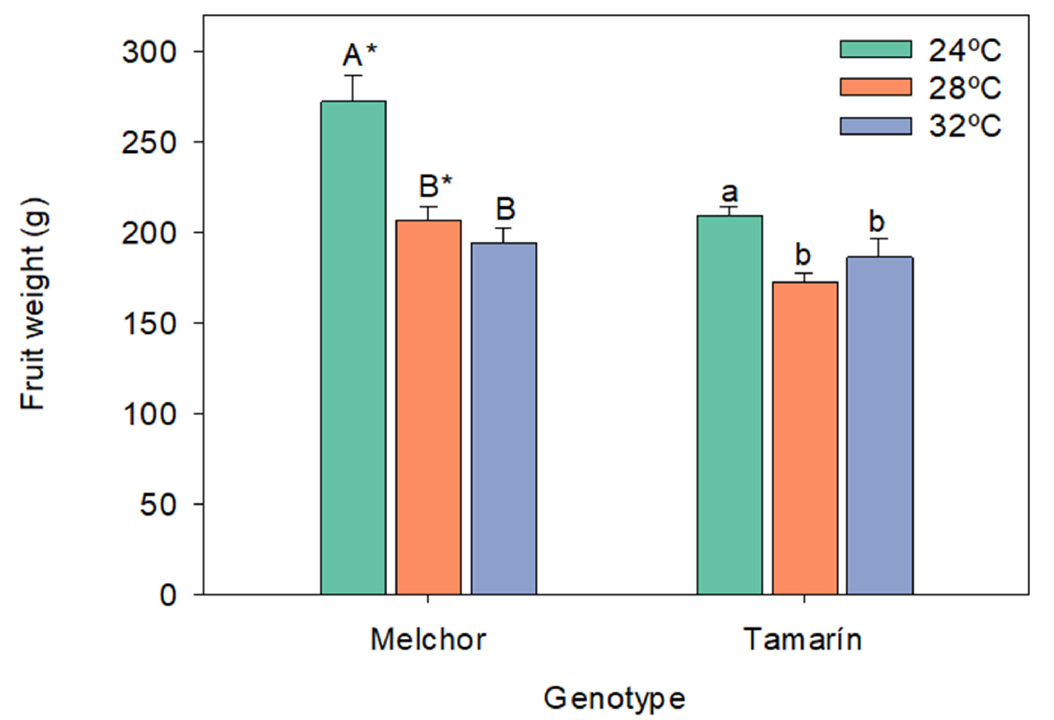
Figure 2. Effect of temperature (24 °C, 28 °C, and 32 °C) on fruit weight of Melchor and Tamarín fruits. The data are presented as the treatment means ( n = 6) ± S.E. Different lowercase letters indicate significant differences between temperatures in Melchor and different uppercase letters indicate significant differences between temperatures in Tamarín. * Denotes significant differences between two cultivars grown under the same temperature conditions.